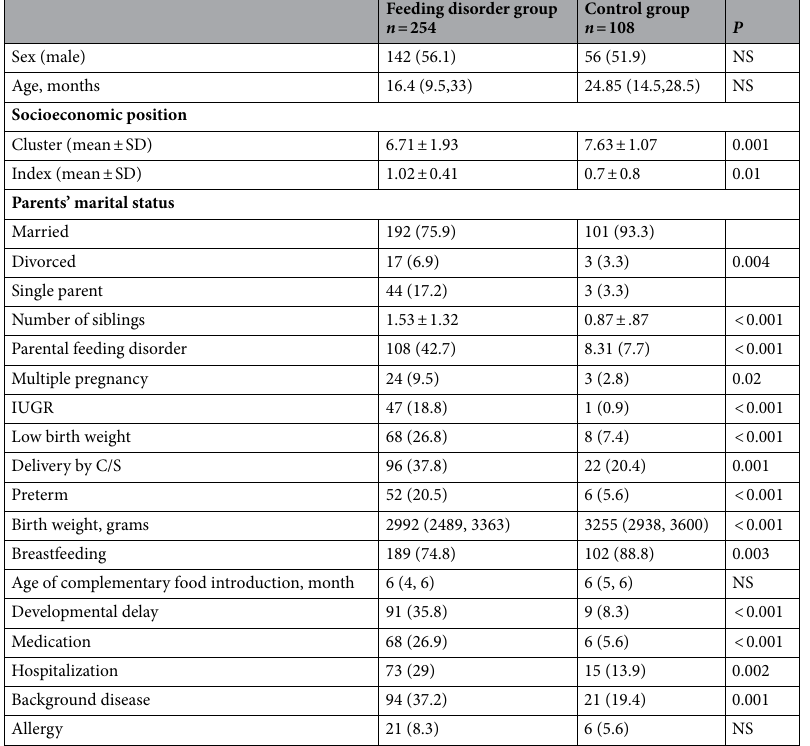
Table 1. Demographic and clinical characteristics of children with feeding disorders compared to controls. The data are expressed as median and interquartile range for continuous variables, and n (%) for categorical variables. IUGR intrauterine growth restriction, C/S cesarean section.